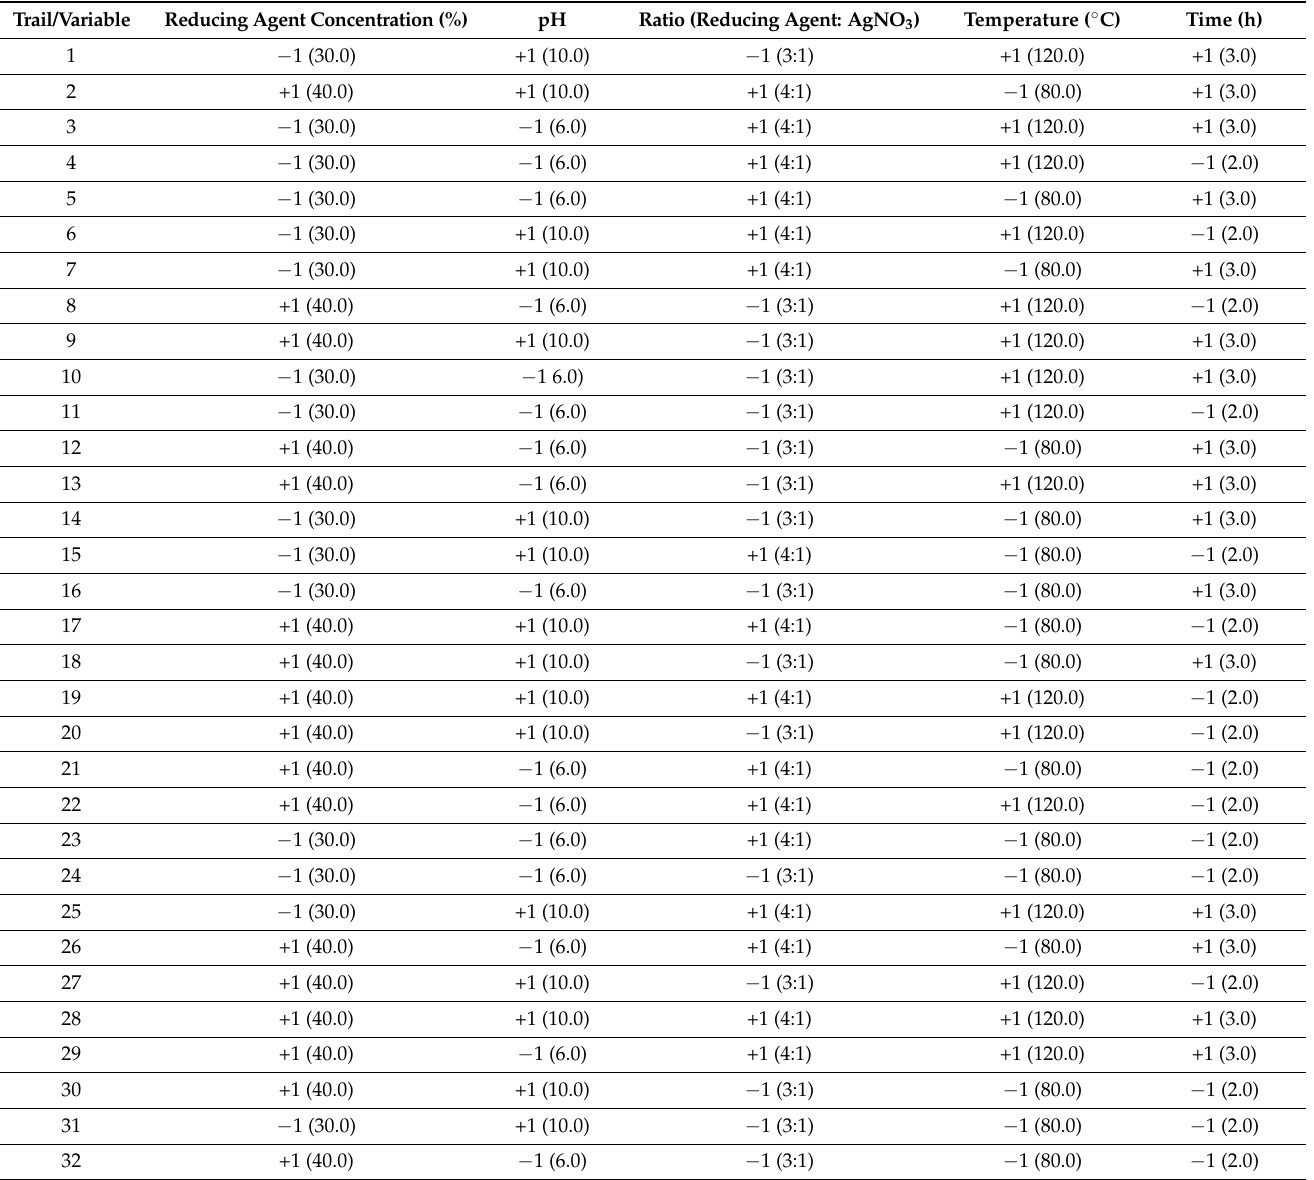
Table 7. Multilevel categoric factorial design of Mo-capped AgNP